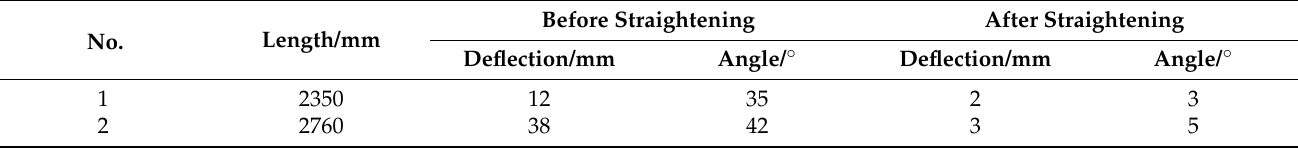
Table 5. Results of verification